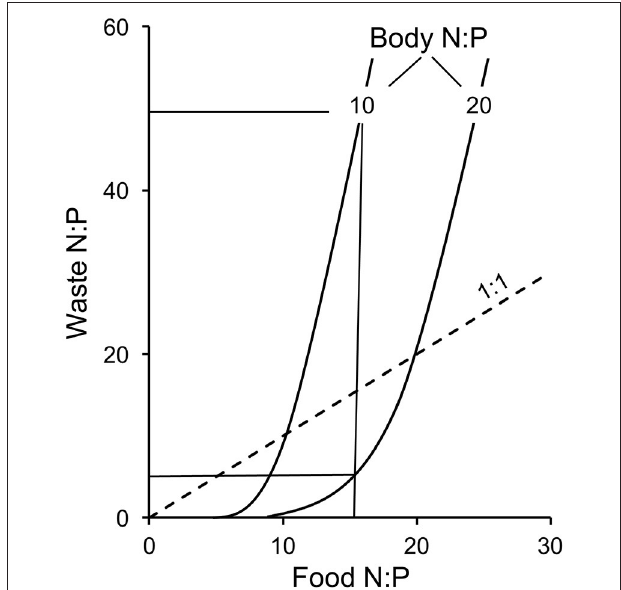
FIGURE 1 | Predicted relationships for the N:P of the consumer’s waste products as a function of its food N:P and body N:P. Two curves for herbivores with body N:P values of 10 and 20 are shown. First, the predicted relationship between waste N:P and food N:P is positive; linear when food N:P > body N:P and curvilinear when food N:P < body N:P. This means that if the herbivore with a body N:P of 20 consumes food with an N:P of 15, it will release wastes with an N:P < 15. In contrast, if the same herbivore ingests food with an N:P of 25, it will release wastes that have an N:P > 25. Secondly, for any given food different consumers will recycle nutrients at different ratios depending on their body N:P ratio. If both herbivores feed on plants with an N:P ratio of 15, the herbivore with the low N:P (10) needs to sequester relatively more P, and will thus release wastes at a much higher N:P, than the herbivore with high body N:P. Redrawn from Sterner and Elser (2002) with permission of